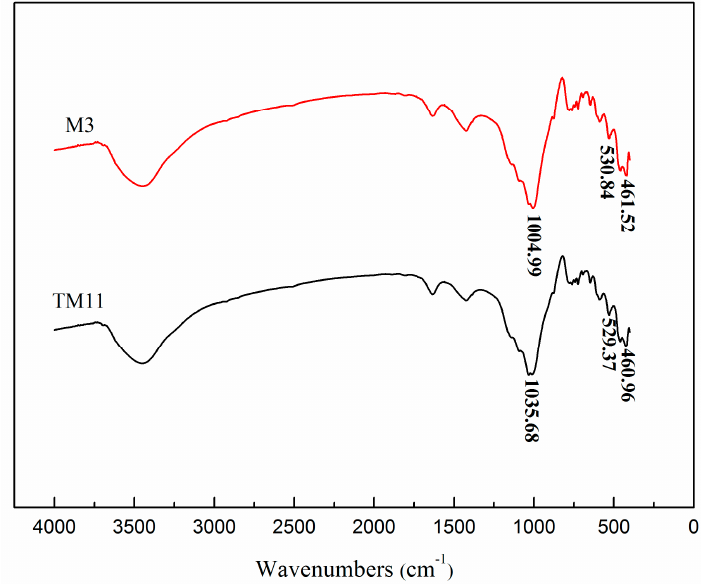
Figure 14. FTIR spectra of the sample M3 (after 3 h of activation, Table 2) and sample TM11 (thermal activation at 600 °C for 120 min, Table 3).